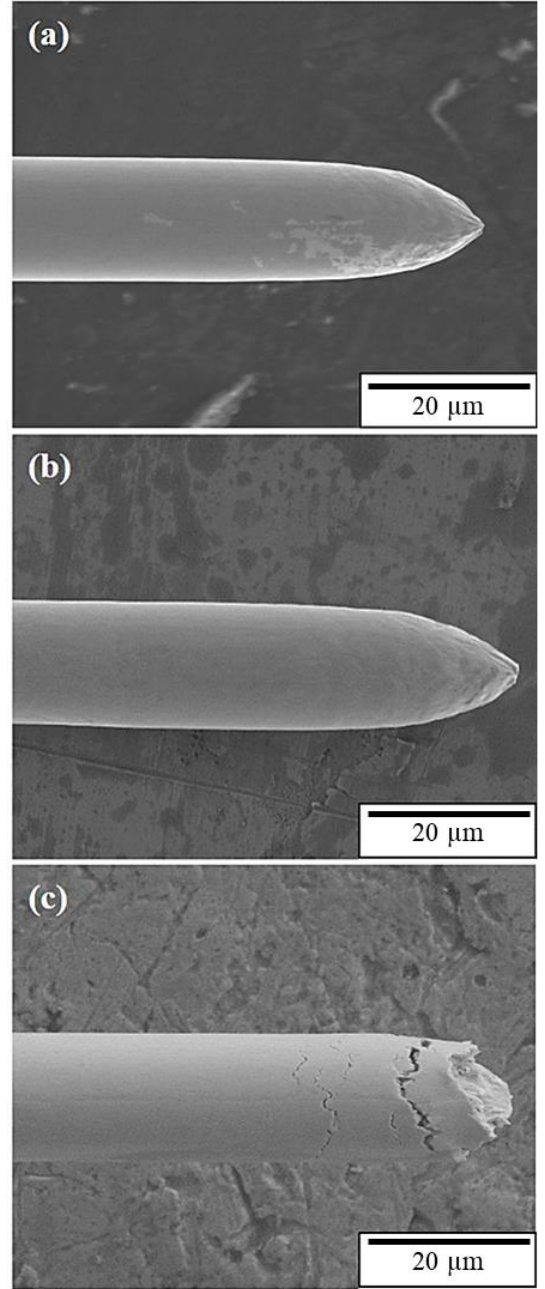
Figure 2. Tensile fracture surface of the APAP wire at different chlorination times: ( a ) before chlorination, ( b ) 2 h, and ( c ) 4 h.